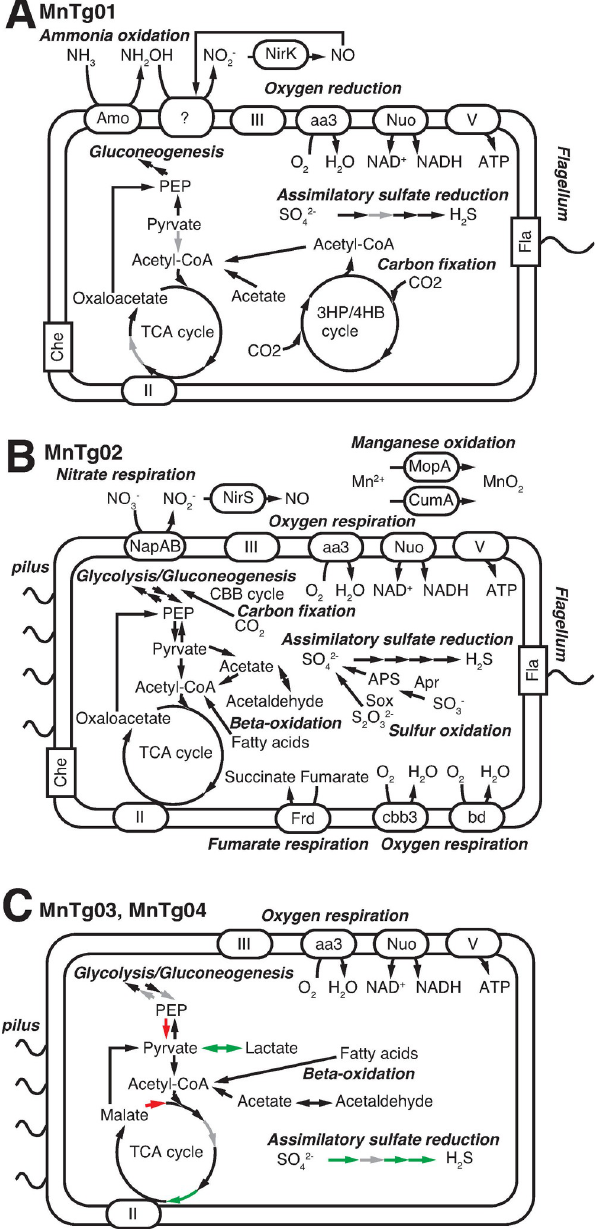
Fig 6. Key metabolic pathways of the four MAGs. (A) MnTg01, (B) MnTg02, (C) MnTg03 and MnTg04. (A and B) The presence and absence of each gene is indicated by black and gray arrows, respectively. (C) Black arrows indicate genes present in MnTg03 and MnTg04. White arrows indicate genes absent in MnTg03 and MnTg04. Green or red arrows indicate genes present only in MnTg03 or MnTg04, respectively. The locus tags and full names of the genes in the pathways are shown in S1